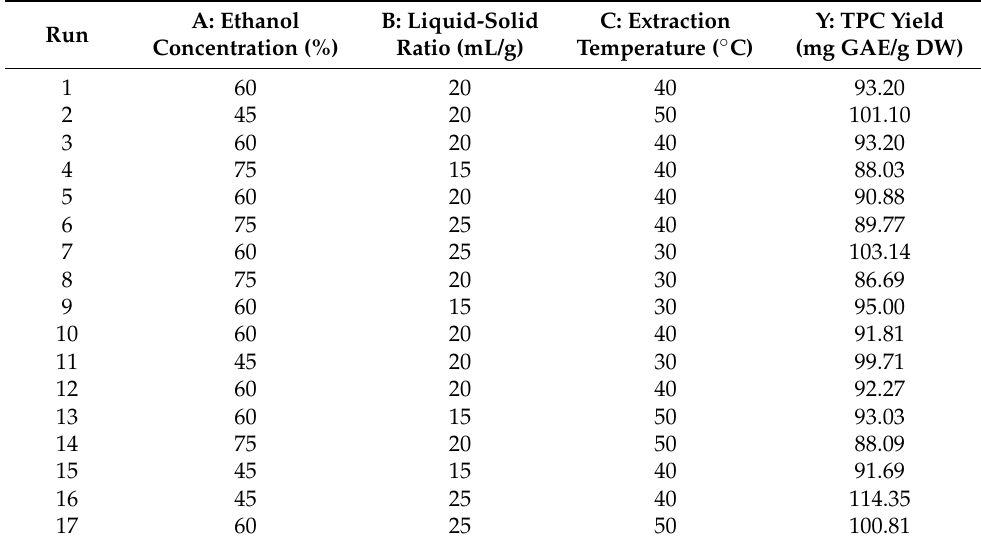
Figure 1. Single-factor experiment on the effect of extraction time ( a ), ethanol concentration ( b ), liquid–solid ratio ( c ), and extraction temperature ( d ) on the extraction yield of total phenolics from PE fruit ( n = 3). Table 1. Coded values for BBD and experimentally observed responses.